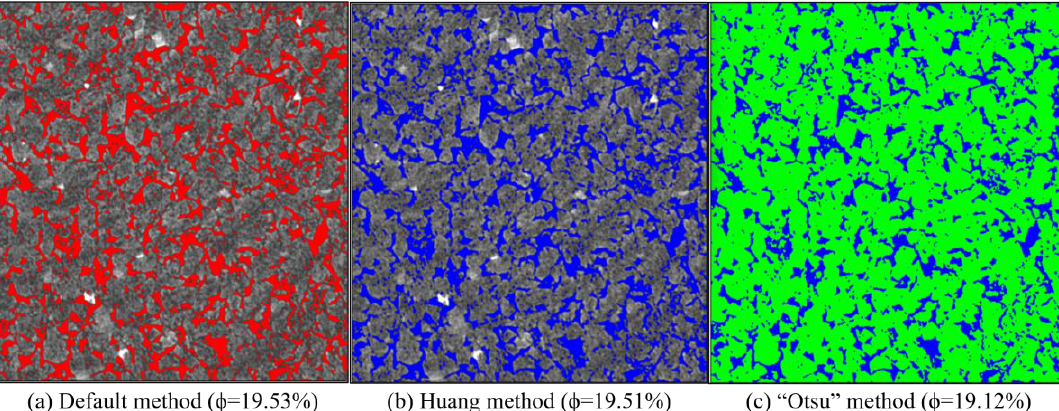
Figure 4. The segmentation results and calculated porosities ( ϕ ) of the 683rd image based on “Default”, “Huang” and “Otsu” methods (the red and blue colors represent pores and the green color represents mineral grains ).